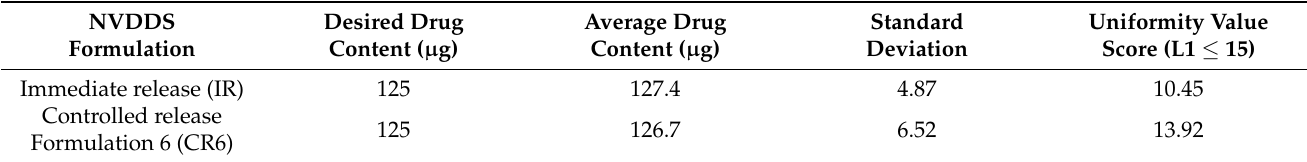
Table 3. Testing selected formulations for tablet uniformity ( n = 10).